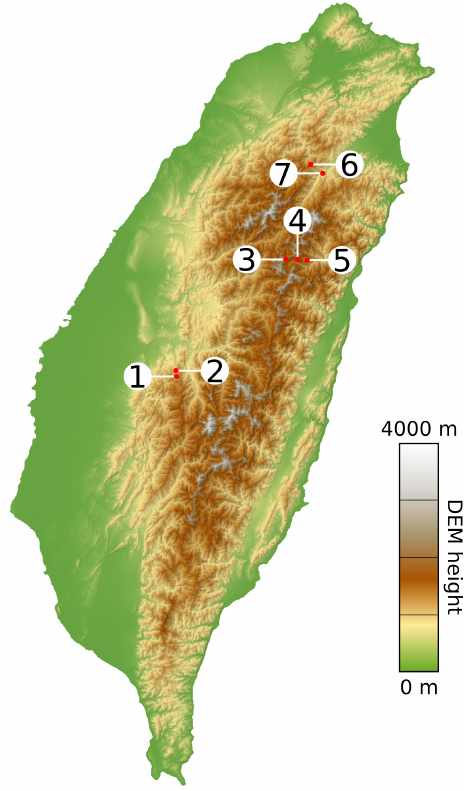
Figure 11. Locations of the instruments used in the validation study.